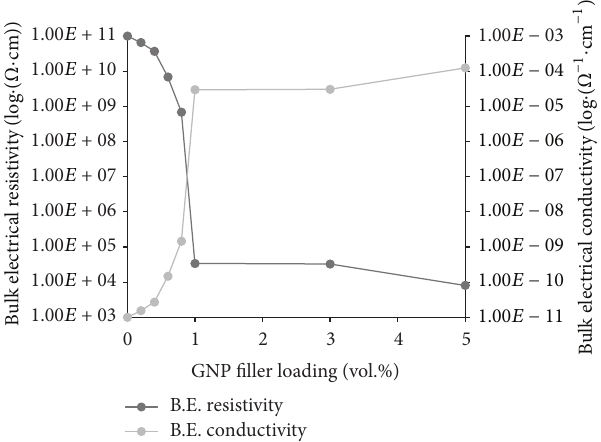
Figure 6: Bulk electrical resistivity and conductivity of GNP filled epoxy